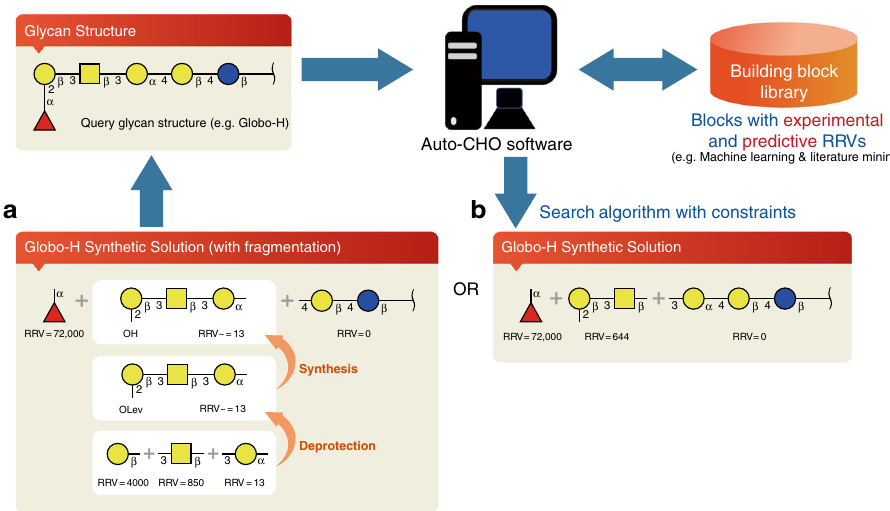
Fig. 2 Illustration of the programmable one-pot synthesis of Globo-H by Auto-CHO. a The synthetic solution shows [1 + 3 + 2] strategy. The internal fragment can be synthesized by another one-pot approach. b The synthetic solution shows [1 + 2 + 3] strategy without further